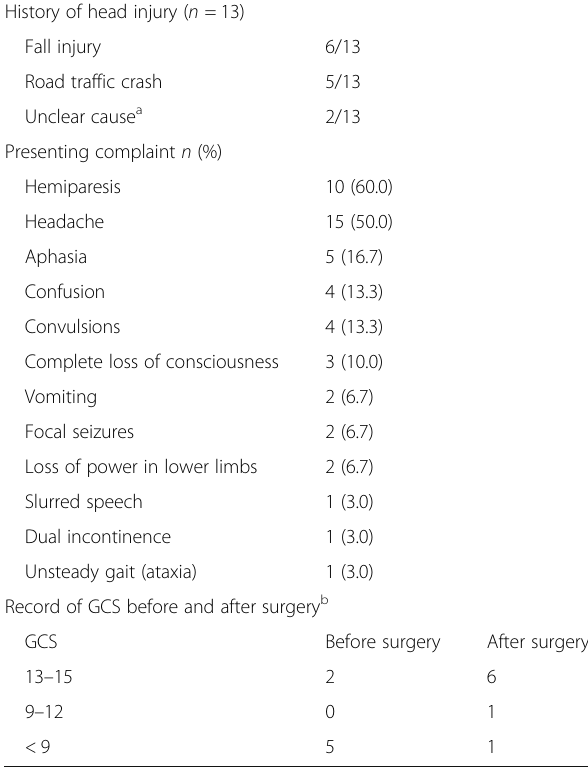
Table 1 Patient ’ s history of head trauma and clinical